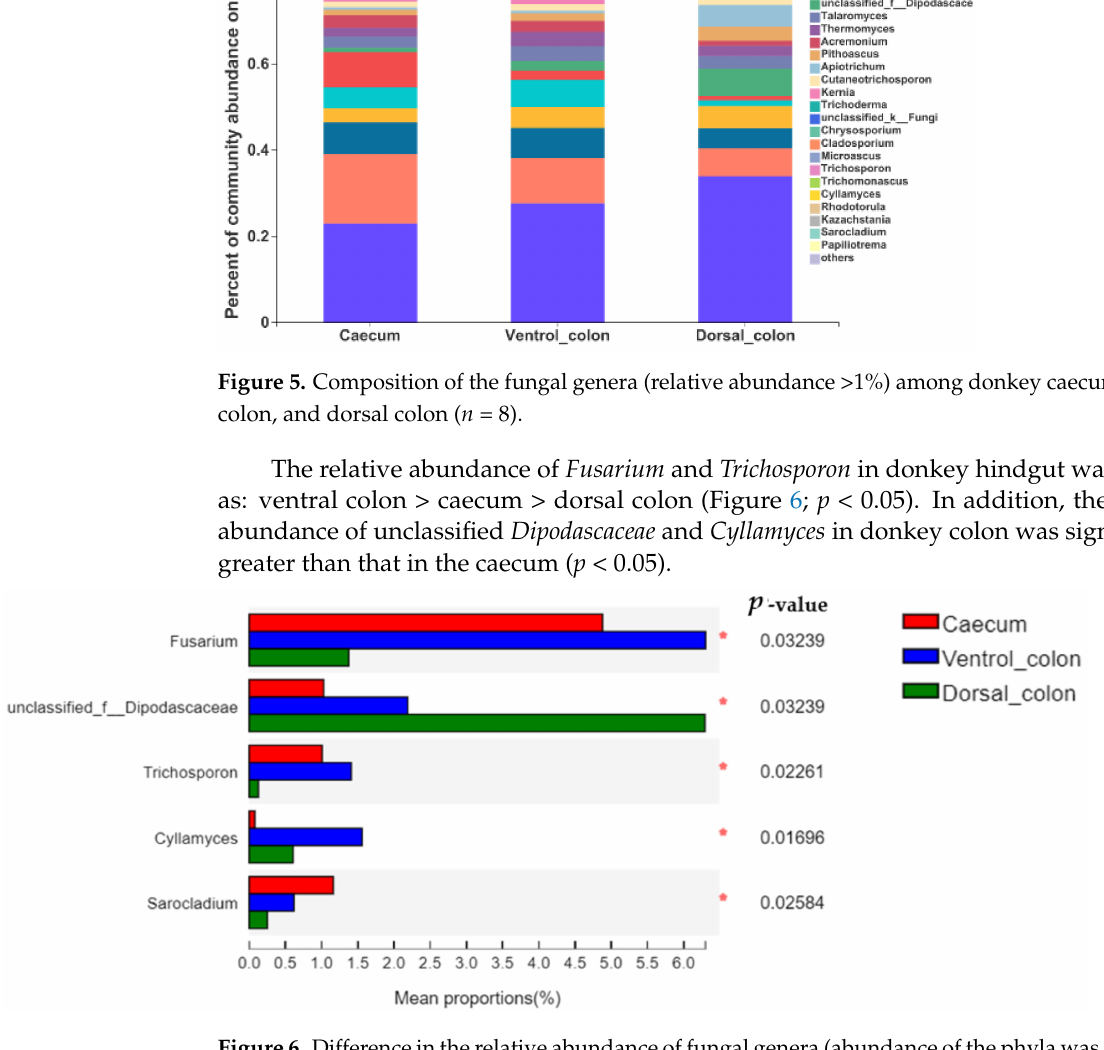
Figure 6. Difference in the relative abundance of fungal genera (abundance of the phyla was expressed as %). Welch’s two-sided test was used and Welch’s inverted was 0.95. *, p <